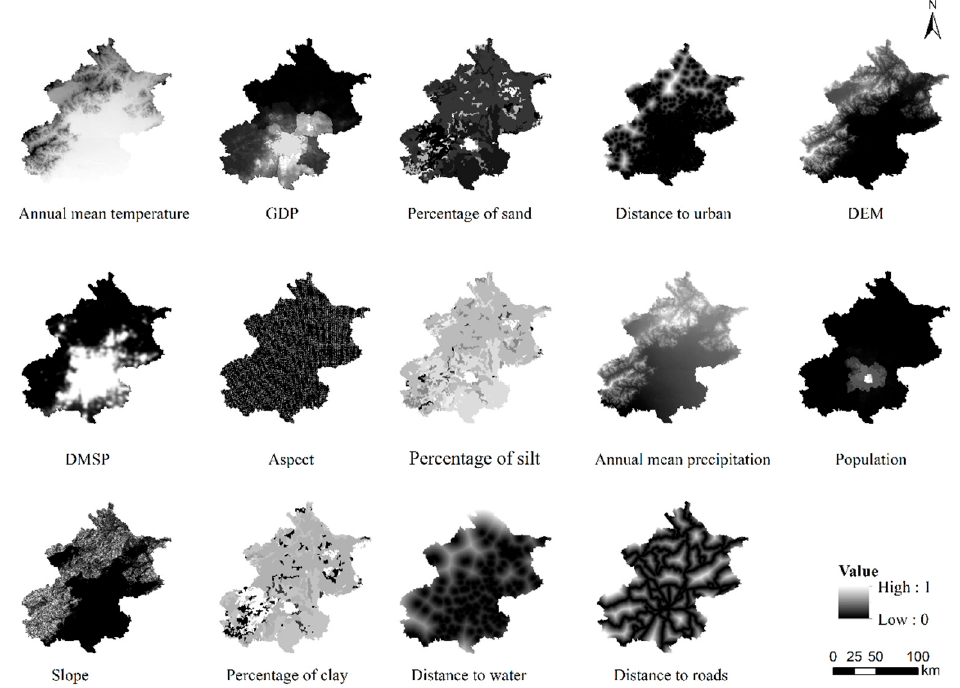
Figure 4. Driving factors of urban expansion.